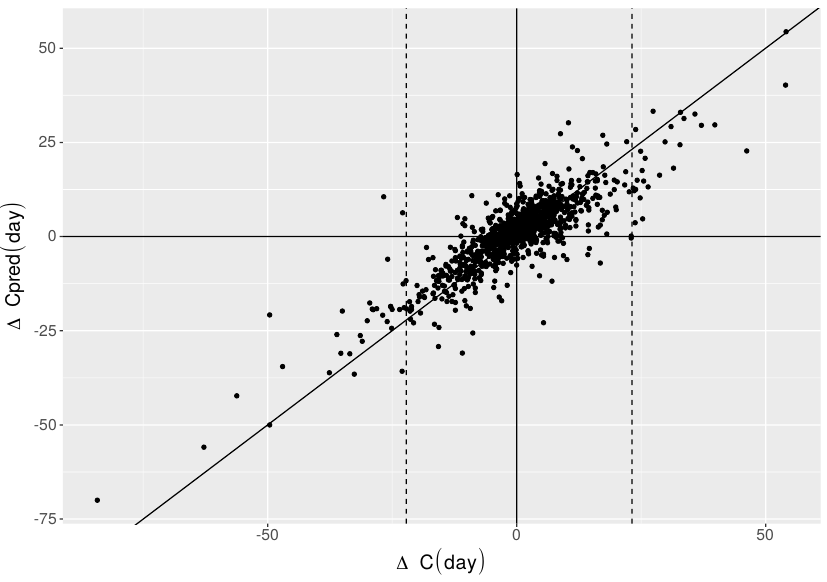
Figure 4. ∆ C(1 day) against ∆ Cpred(1 day) for Ljubljana as predicted by the random forest